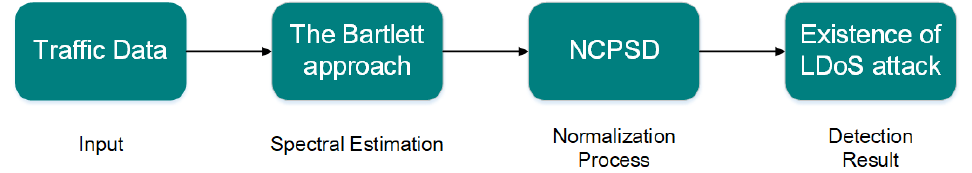
Figure 2. The flow chart of LDoS attack detection. The Bartlett approach is used to obtain the PSD of traffic data, and then normalized cumulative power spectrum density (NCPSD) is gained after the normalization process. Judge whether there is an attack by analyzing the distribution of NCPSD in low frequency domain at